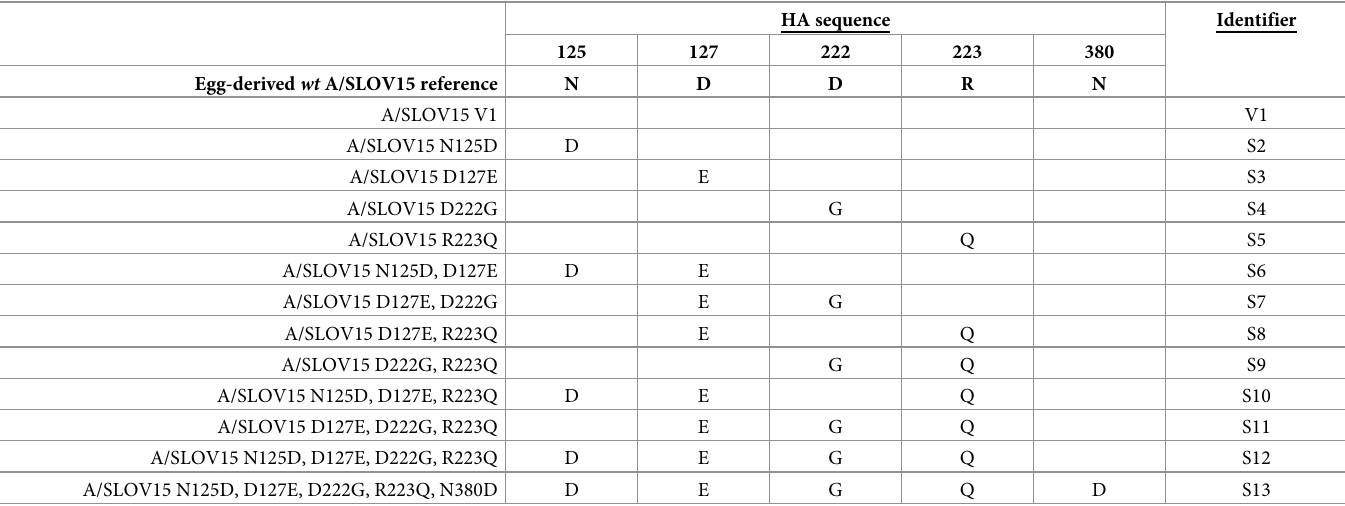
Table 1. Summary of A/SLOV15 LAIV mutant HA sequences.